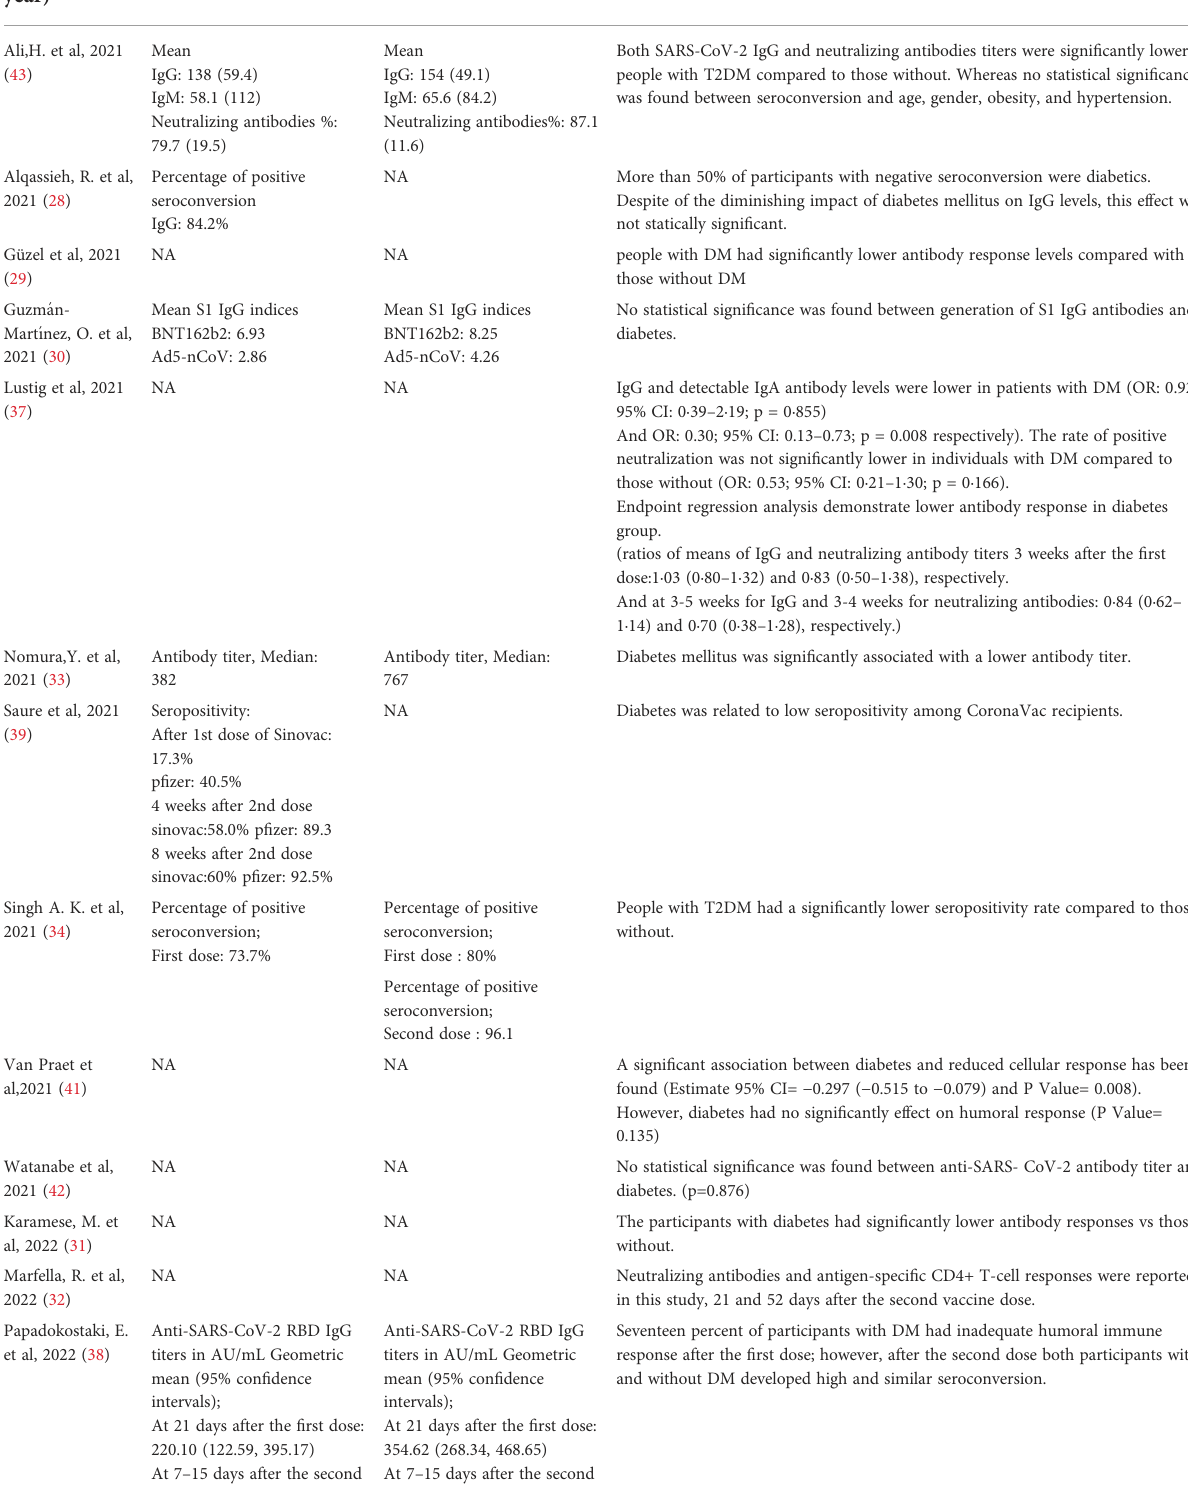
TABLE 3 Outcomes of the included studies in DM patients vs. patients without